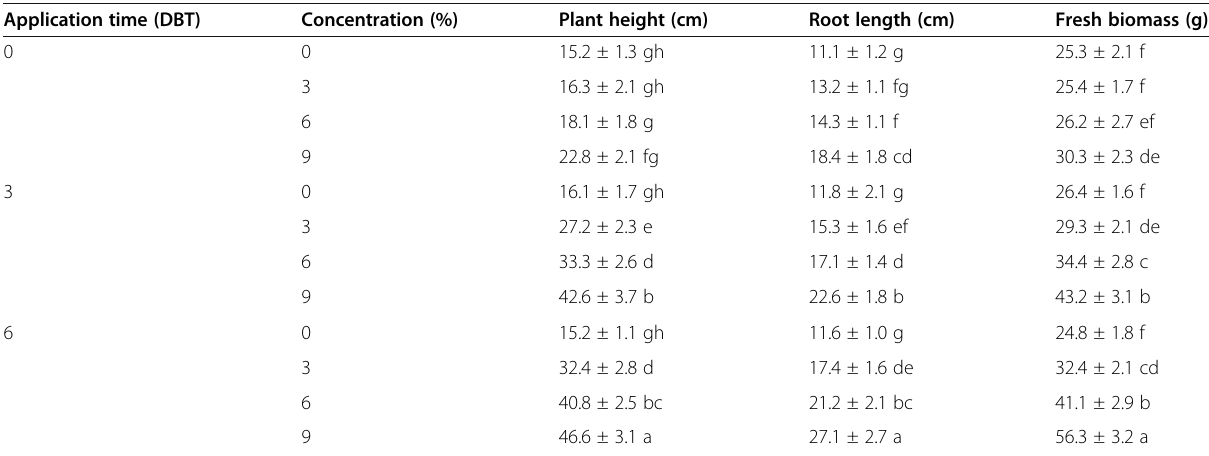
Table 3 Effect of fungal metabolites on the growth of tomato plants inoculated with R. solanacearum under greenhouse conditions (experiment